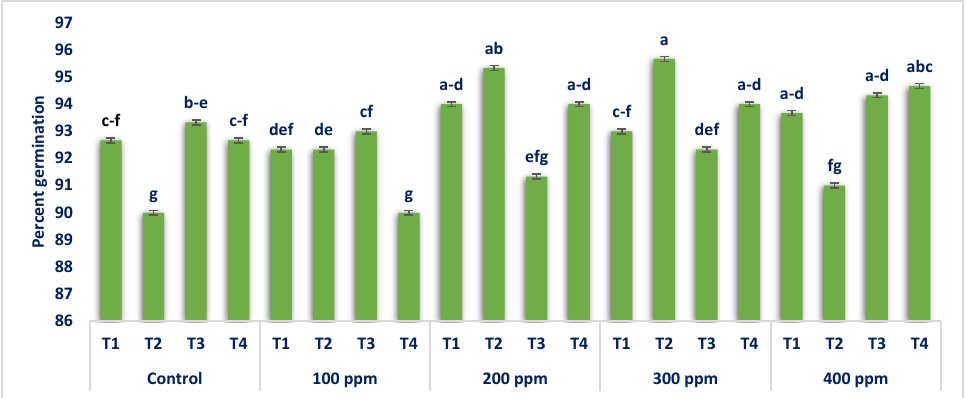
Figure 3. Interaction effect of GA 3 concentration and time of application during cultivation on the germination of produced cauliflower seeds. Means followed by same letter(s) within a column do not differ significantly at 5% level of probability by DMRT. T 1 = GA 3 application at 3 weeks after transplanting, T 2 = GA 3 application at 4 weeks after, T 3 =GA 3 application at 5 weeks after transplanting, and T 4 = GA 3 application at 6 weeks after transplanting.